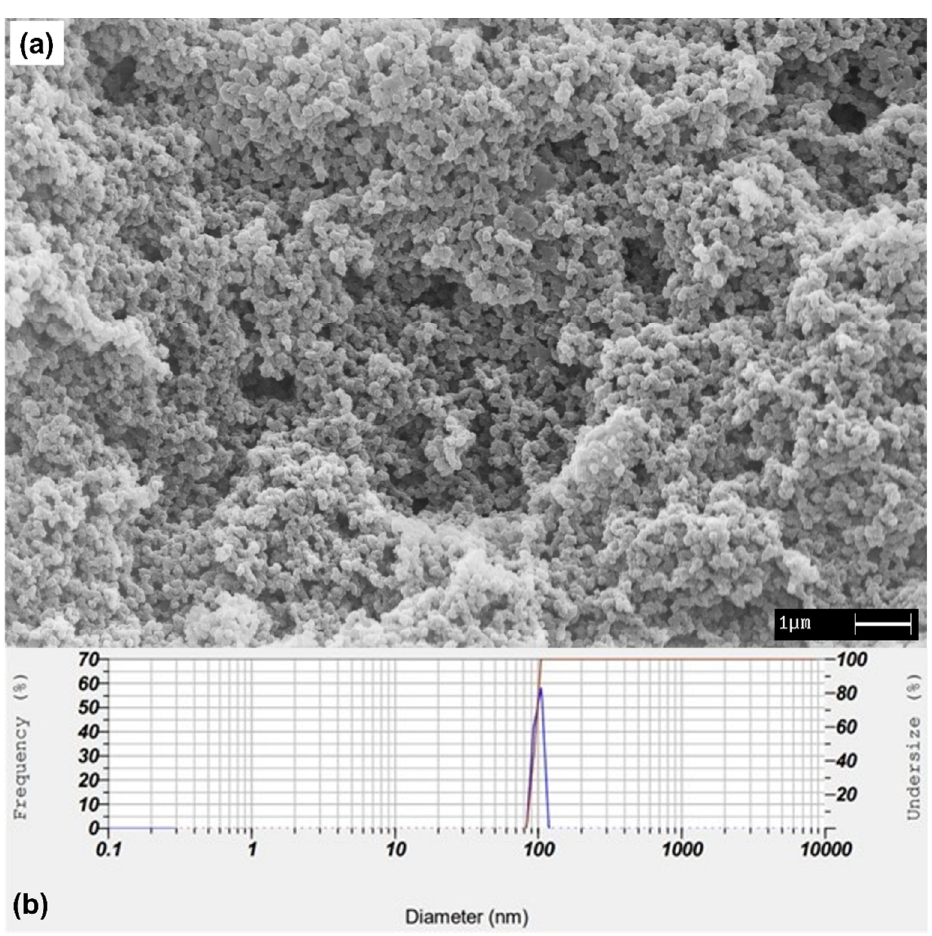
Figure 2. ( a ) SEM image (20,000×) and ( b ) DLS size distribution of the synthetized β CP–NP obtained by precipitation polymerization.